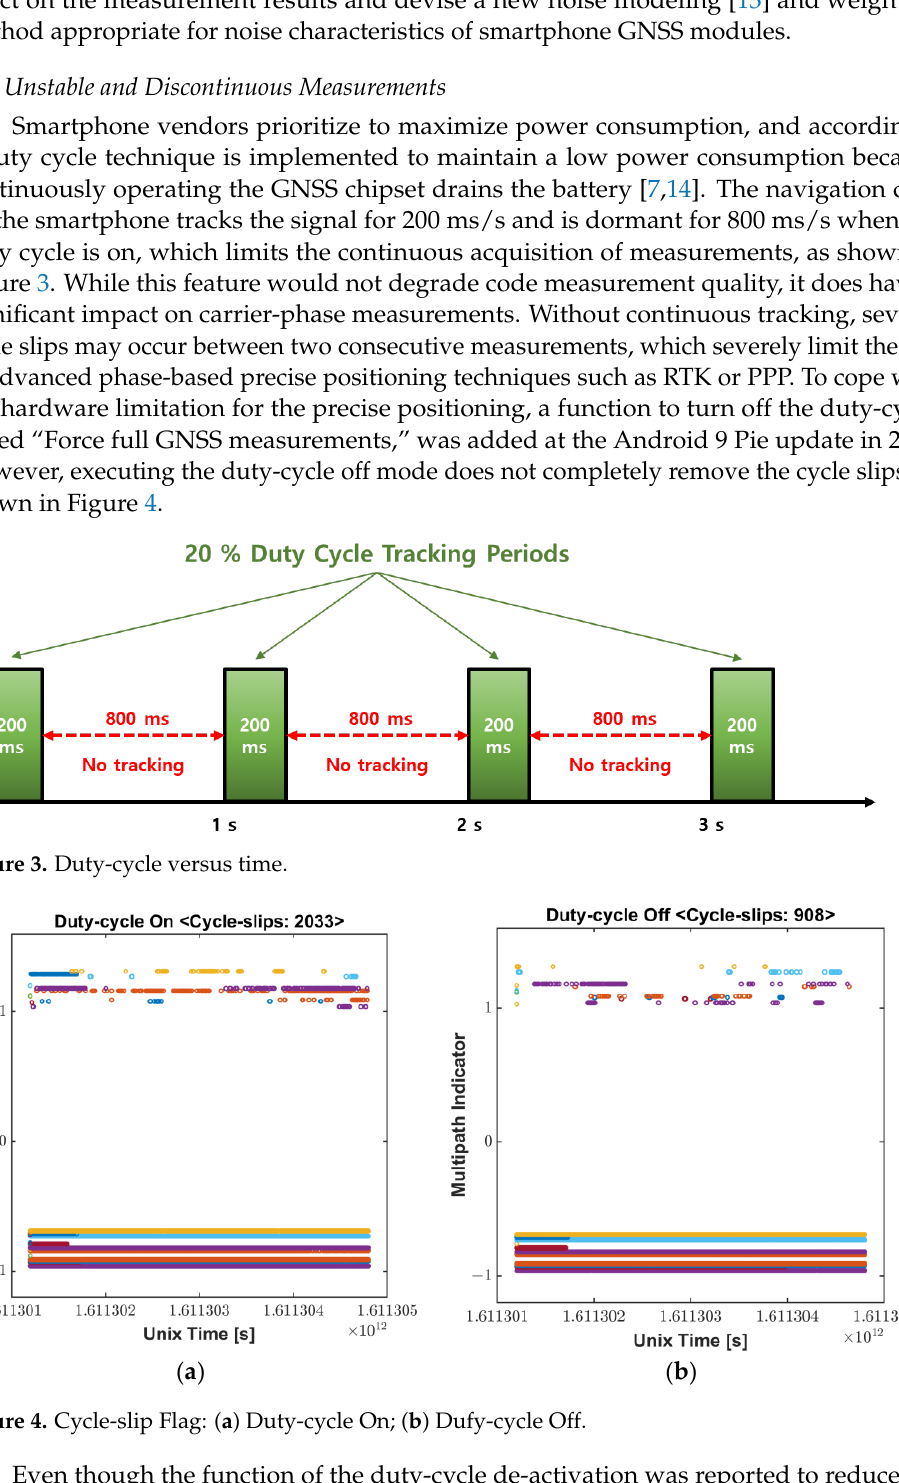
Table 1. SNR and Noise-level with or without GNSS repeater results.